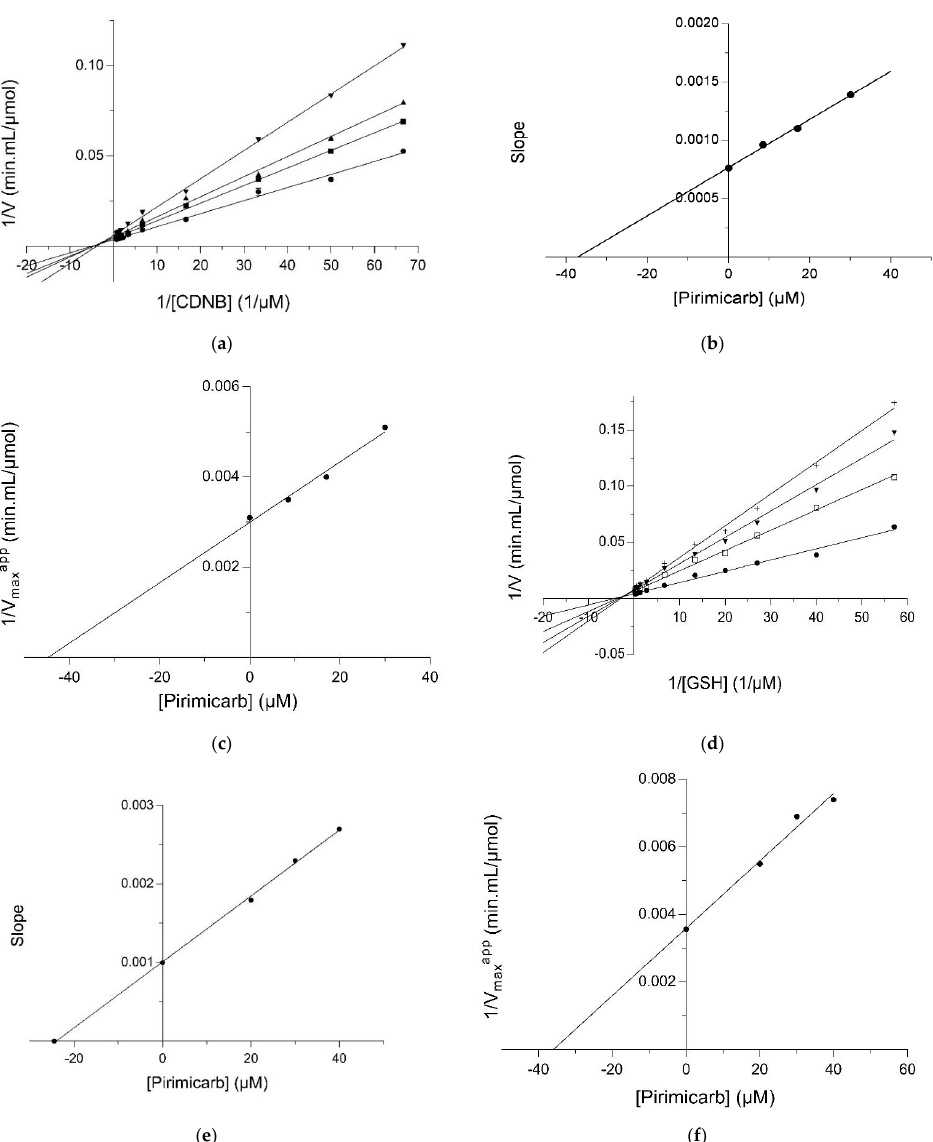
Figure 3. Kinetic inhibition study. ( a ): Lineweaver – Burk plot for the inhibition of hGSTM1-1 with pirimicarb at different CDNB concentrations. Pirimicarb concentrations: 0 μΜ, (●); 8.5 μΜ, ( ■ ); 17 μΜ, ( ▲ ); 30 μΜ, ( ▼ ); ( b ): Secondary (derivative) diagram. The data obtained from the Lineweaver – Burk diagram. The point of intersection with the x -axis corresponds to the K i inhibitory constant; ( c ): Secondary (derivative) diagram. The data obtained from the Lineweaver – Burk diagram. The point of intersection with the x -axis corresponds to the K i ’ inhibitory constant; ( d ): Lineweaver – Burk plot for the inhibition of hGSTM1- 1 by pirimicarb at different GSH concentrations. 0 μΜ, (●); 20 μΜ, ( □ ); 30 μΜ, ( ▼ ); 40 μΜ, († ); ( e ): Secondary (derivative) diagram. The data were obtained from the Lineweaver – Burk diagram. The point of intersection with the x -axis corresponds to the K i inhibitory constant; ( f ): Secondary (derivative) diagram. The data obtained from the Lineweaver – Burk diagram. The point of intersection with the x -axis corresponds to the K i ’ inhibitory constant.